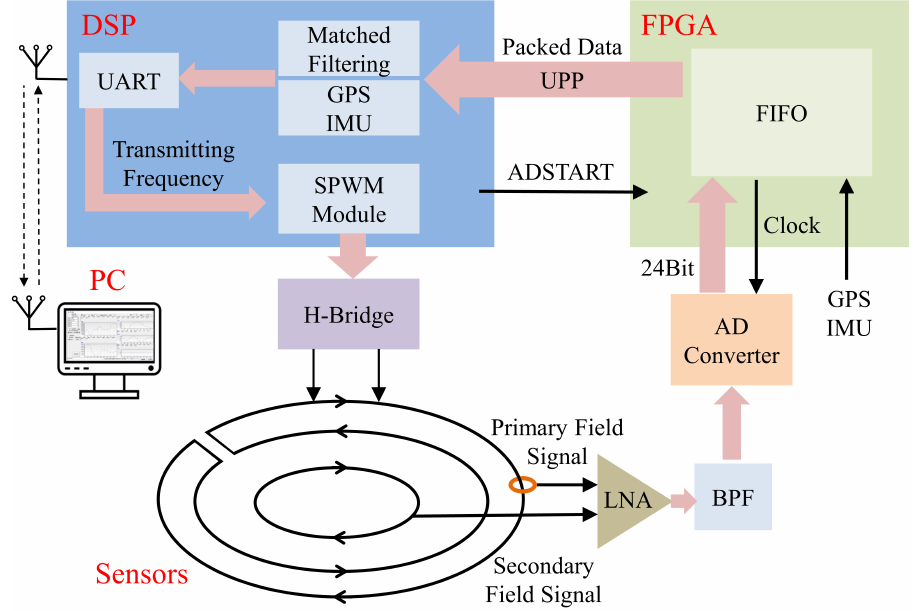
Figure 4. Schematic diagram of the AFEM-3 system